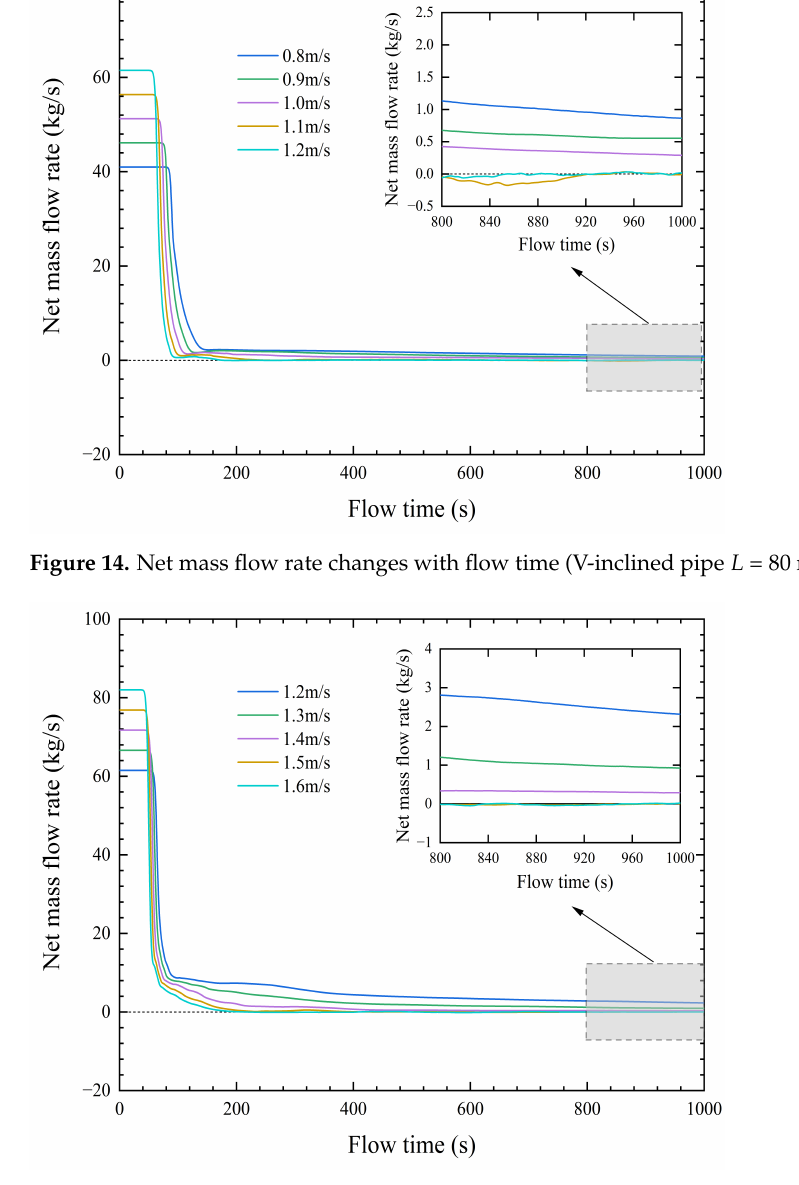
Figure 15. Net mass flow rate changes with flow time (V-inclined pipe L = 80 m d = 0.1